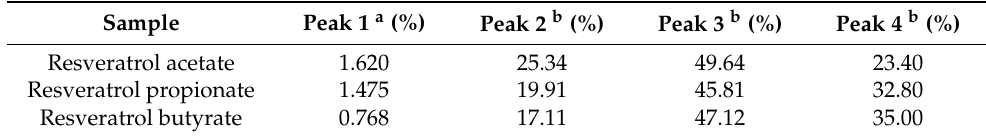
Table 1. Resveratrol ester peak area